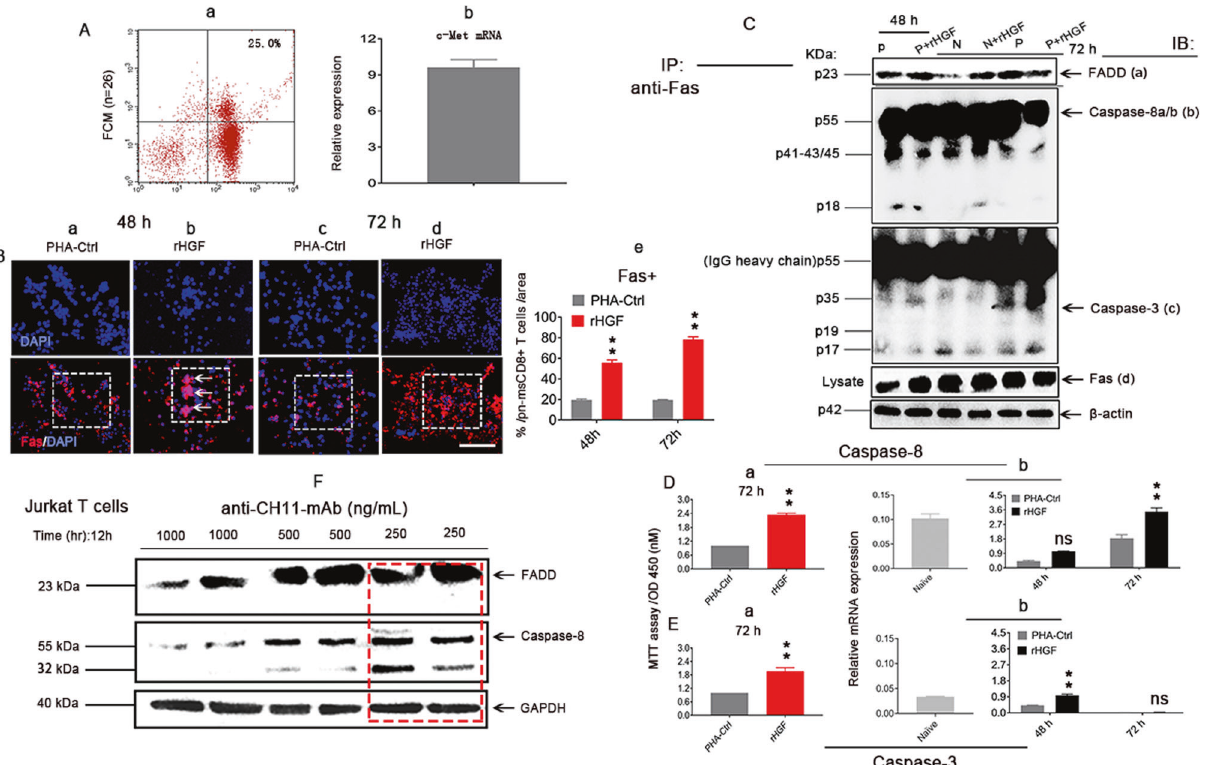
Fig. 3 rHGF (400 ng/mL) enhances DISC formation to promote Fas-mediated apoptosis in both naive and PHA-stimulated msCD8 + T cells. A (a, b) c-Met expression in n-msCD8 + T cells at the protein (a, n = 3) and mRNA (b, n = 3) levels identi fi ed by FCM and qRT ‒ PCR assays, respectively. B (a – e) Immuno fl uorescence staining for Fas expression (red) in MACS-puri fi ed pn-msCD8 + T cells (denoted in blue) after 48 (a, b, boxes, arrows denote Fas aggregation) and 72 h (c, d, boxes) of 400 ng/mL rHGF treatment and quanti fi cation (e) compared with the PHA- control groups. Scale bar = 200 µM, n = 6/time point; C (a – d) IP with a Fas antibody followed by IB for FADD (a, n = 2), caspase-8 (b, n = 2), and caspase-3 (c, n = 2) of cell lysates only for Fas control protein (d, n = 2) after 48 h of 400 ng/mL treatment. D (a, b) MTT assay (a) and RT-qPCR (b) were used for the assessment of caspase-8 expression in the presence or absence of 400 ng/mL rHGF for 48 (b) and 72 h (a, b), n = 10. E (a, b) MTT assay (a) and RTq-PCR (b) were performed for the assessment of caspase-3 expression in the presence or absence of 400 ng/mL rHGF for 48 (b) and 72 h (a, b), n = 10. F Anti-CH11-mAb (250 ng/mL, red box) was selected for the treatment of Jurkat T cells (J) based on the experimental results to determine the ideal concentration, n = 2. At least three independent experiments were performed, and the data